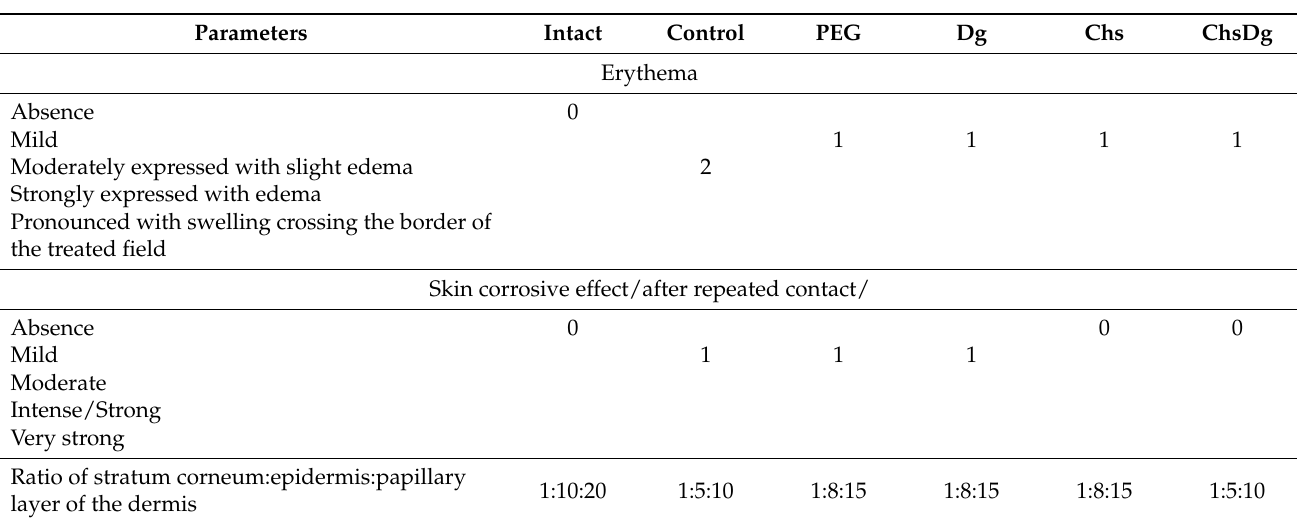
Table 1. Skin status regarding erythema and corrosive effect.